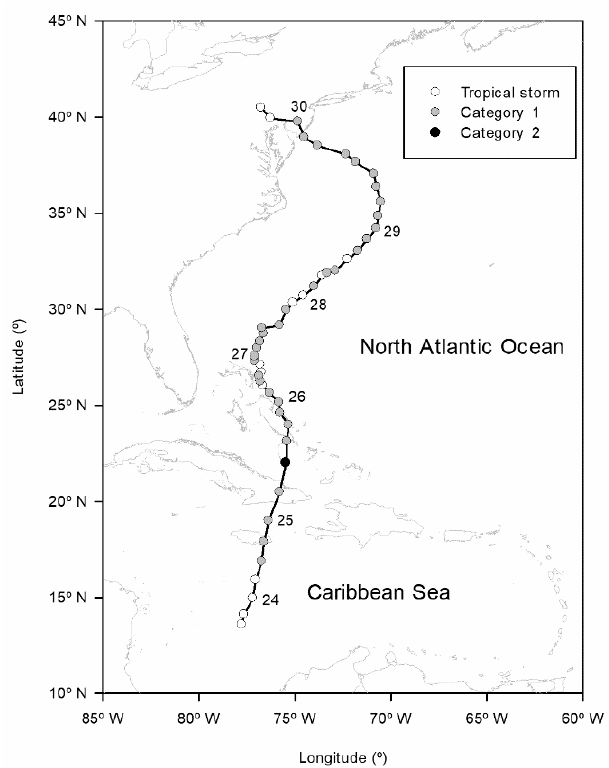
Figure 3. Trajectory of Hurricane Sandy based on the HWind files together with its category. Its location at the beginning of the corresponding day is also presented. During 27 and 28 October 2012, the trajectory was parallel to the coast. However, it turned west on 29 October 2012 to reach the coast following an infrequent landfall.